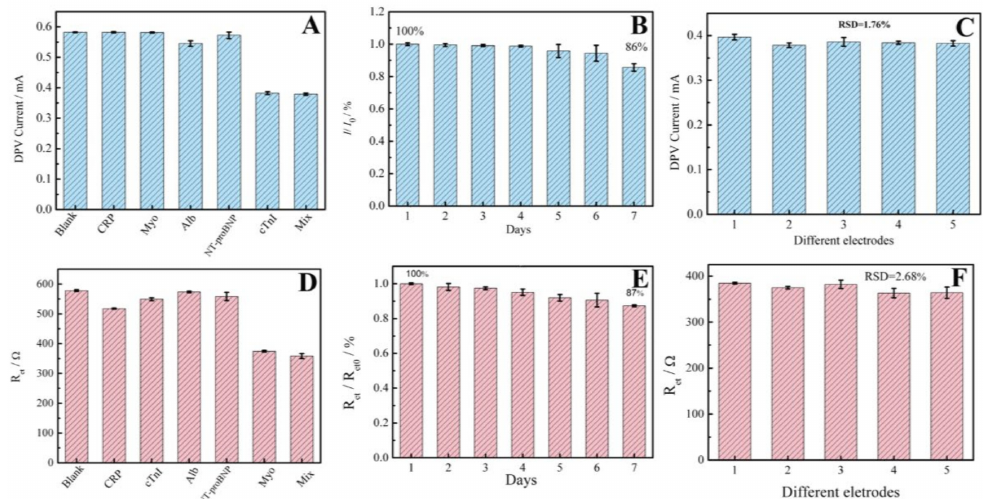
Figure 4. The ( A ) selectivity (in the presence of 60 pg /mL CRP, Myo, Alb and NT-proBNP), ( B ) stability and ( C ) reproducibility of the cTnI aptasensor for cTnI (600 fg/mL) detection, all detected values are presented as blue bars. The ( D ) selectivity (in the presence of 50 ng/mL CRP, cTnI, Alb and NT-proBNP), ( E ) stability and ( F ) reproducibility of the Myo aptasensor for Myo (5 ng/mL) detection, all detected values are presented as red